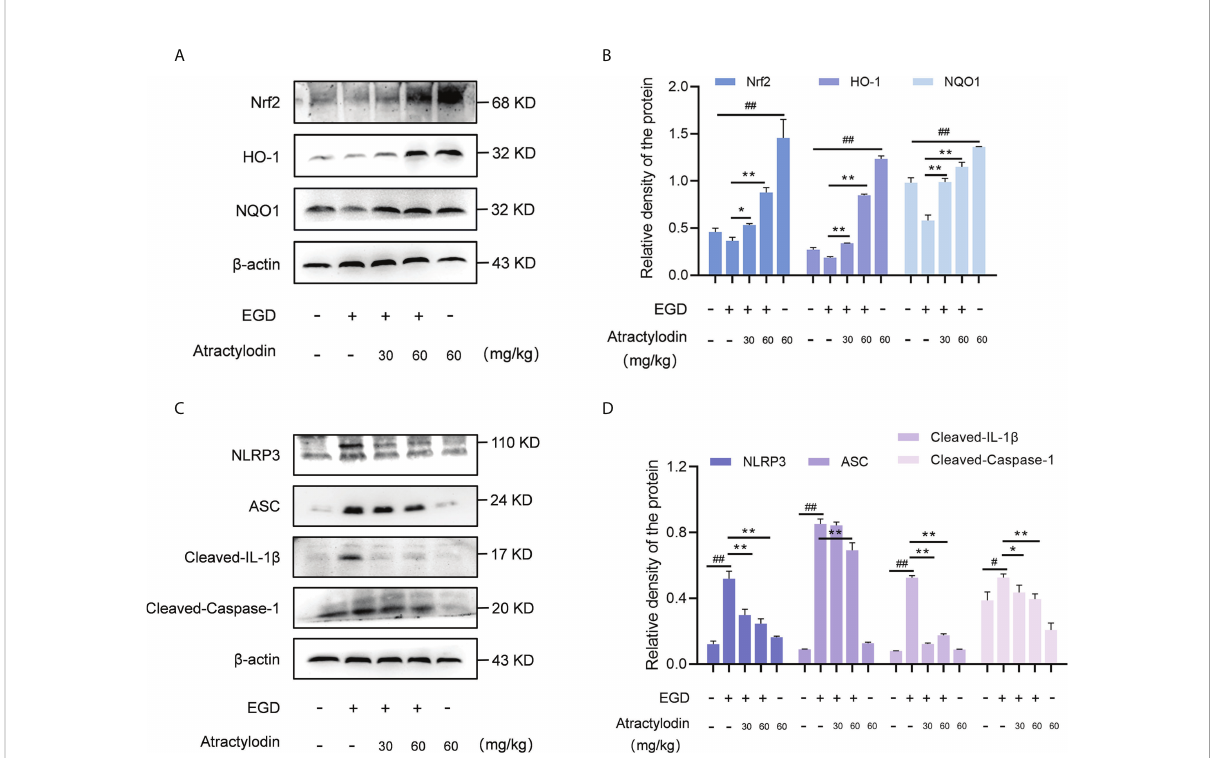
FIGURE 5 Effects of atractylodin treatment on Nrf2/NLRP3 signaling pathways in L. monocytogenes EGD-infection mice. At 48 h post-infection, liver tissues of mice were collected and analyzed by western blotting. (A, B) Effects of atractylodin on Nrf2, HO-1 and NQO1 protein expression in the livers. (C, D) Western blot analysis of NLRP3 in fl ammasome activation induced by L. monocytogenes infection in the presence of indicated concentrations of atractylodin. (B, D) Quanti fi cation of relative protein was determined by densitometric analysis. b -actin was served as an internal control. All data were expressed by mean ± SEM. # P < 0.05 and ## P < 0.01 vs the vehicle control group; * P < 0.05 and ** P < 0.01 vs EGD-infection